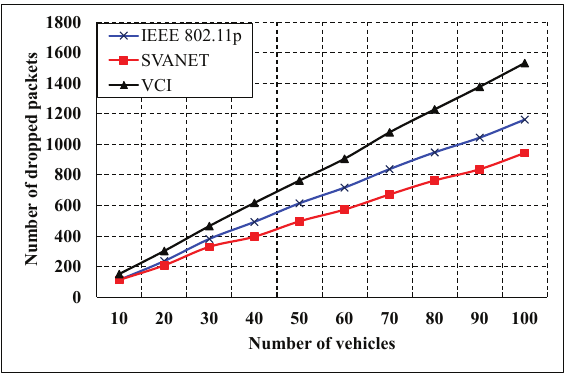
Figure 14. The number of packets dropped at the SRSU when the CCH interval is between 1 ms and 100